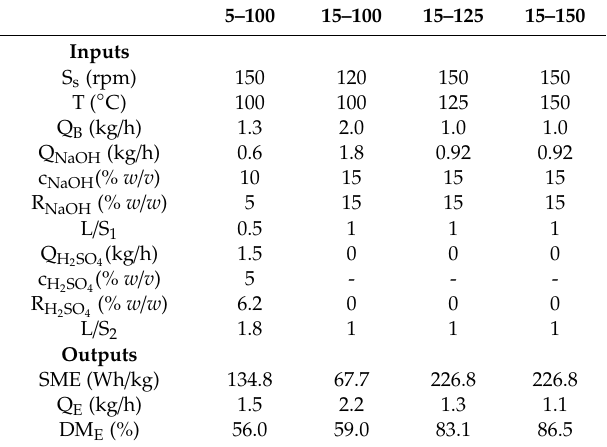
Table 2. Operation inputs and outputs in the alkaline extrusion of olive stone (OS)